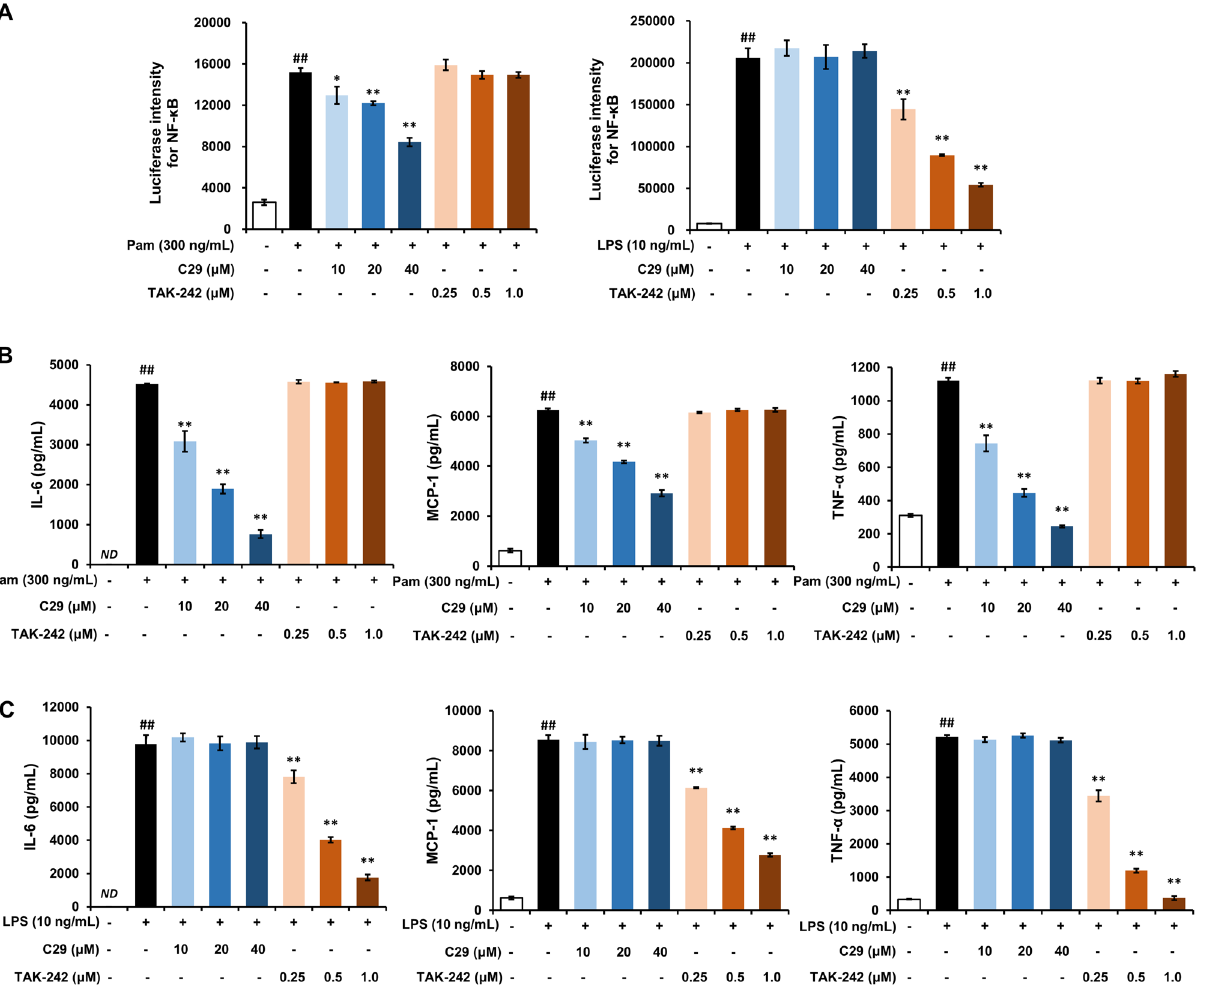
Figure 2. Effects of C29 and TAK-242 on Pam- or LPS-induced pro-inflammatory reactions in RAW264.7 macrophages. ( A ) Effects of C29 and TAK-242 on Pam- or LPS-induced NF-κB activation in RAW264.7 macrophages. ( B ) Effects of C29 and TAK-242 on Pam-elevated supernatant IL-6, MCP-1 and TNF-α in RAW264.7 macrophages. ( C ) Effects of C29 and TAK-242 on LPS-elevated supernatant IL-6, MCP-1 and TNF-α in RAW264.7 macrophages. Mean ± SD (n = 3). ## P < 0.01 vs . negative control; * P < 0.05 and ** P < 0.01 vs . Pam or LPS alone. ND , not